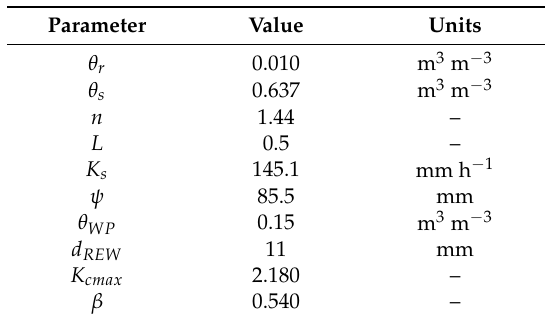
Table 2. Substrate parameters common to all specimens. θ r is the residual substrate water content, θ s is the saturated substrate water content, n is the curve share parameter, L is the empirical pore tortuosity, K s is the saturated hydraulic conductivity, ψ is the bubbling pressure, θ WP is the wilting point, d REW is the readily evaporated water, K cmax is the maximum crop coefficient and β is the adjustment coefficient of the second stage of